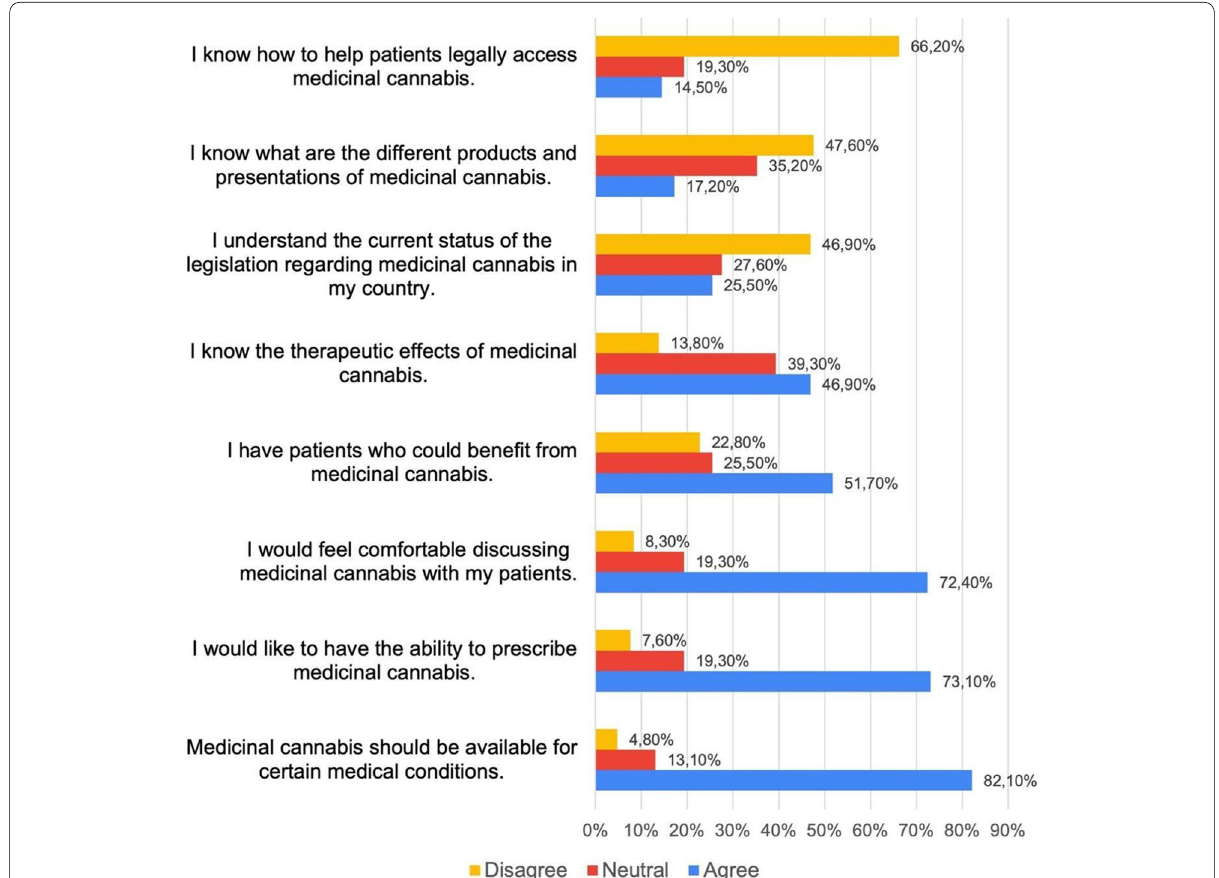
Fig. 1 Attitudes and knowledge perception with respect to medicinal cannabis among 145 Colombian psychiatrists. The survey showed that the majority of Colombian psychiatrists believe that MC should be available for different medical conditions. However, there is a lack of knowledge